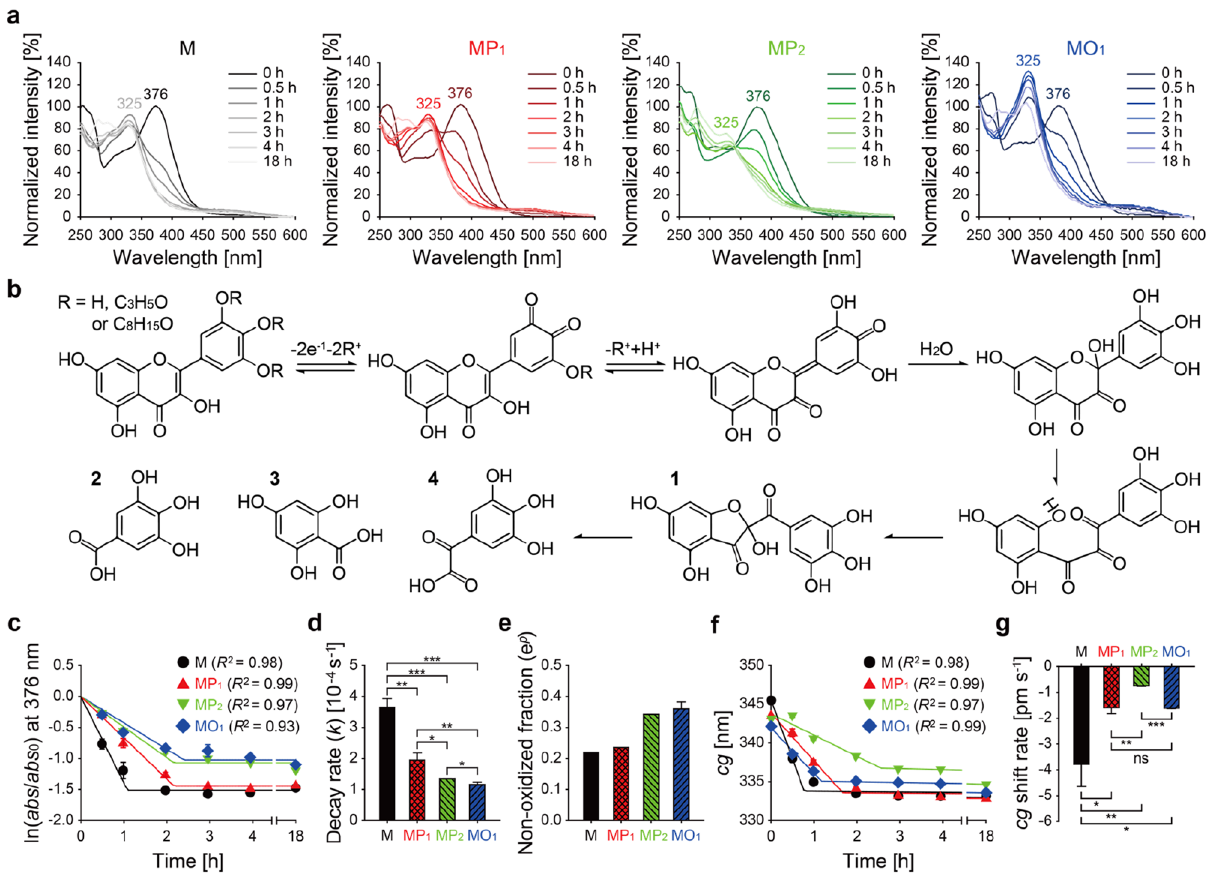
Figure 4. Physicochemical stability of acyl myricetins. ( a ) Changes in the absorbance spectra of M, MP 1 , MP 2 and MO 1 after incubation in aqueous condition. Acyl myricetins, dissolved in DMSO, were diluted into PBS and immediately incubated for 18 h (pH 7 and 37 °C), followed by measurement of UV/Vis-light absorbance spectra at a wavelength ranged from 250 to 600 nm. ( b ) Expected schematic representation of the oxidation procedure for myricetin and its acylated forms (compounds 1 ‒ 4, expected oxidation products). ( c ) Exponential decay-plateau fitting curves [ ln ( abs / abs 0 ) = − kt (cid:31) 0 ≤ t < t p (cid:30) = p ( t p ≤ t ) ; abs , absorbance (wavelength, 376 nm) at the incubation time ( t ); abs 0 , absorbance at initiation of the incubation; k , decay rate constant; p , constant on the plateau] of the tested compounds for the absorbance spectra. ( d ) Decay rate constants ( k ) and ( e ) non-oxidized fraction ratios ( e p ) determined from the decay fitting curves. ( f ) Shifting of the center of gravity for the absorbance spectra, which was determined using the two segment linear fitting curves [ cg = k 1 t + cg 1 ( 0 ≤ t < t 1 ) = k 2 t + cg 2 ( t 1 ≤ t ) ]. ( g ) The cg shift rates determined from the two segment linear fitting curves. Student’s t -test: ns, non-significant, p > 0.05; *, p < 0.05; **, p < 0.01; and ***, p < 0.001 ( d , g ). Data are expressed as the mean ± s.d ( c – g